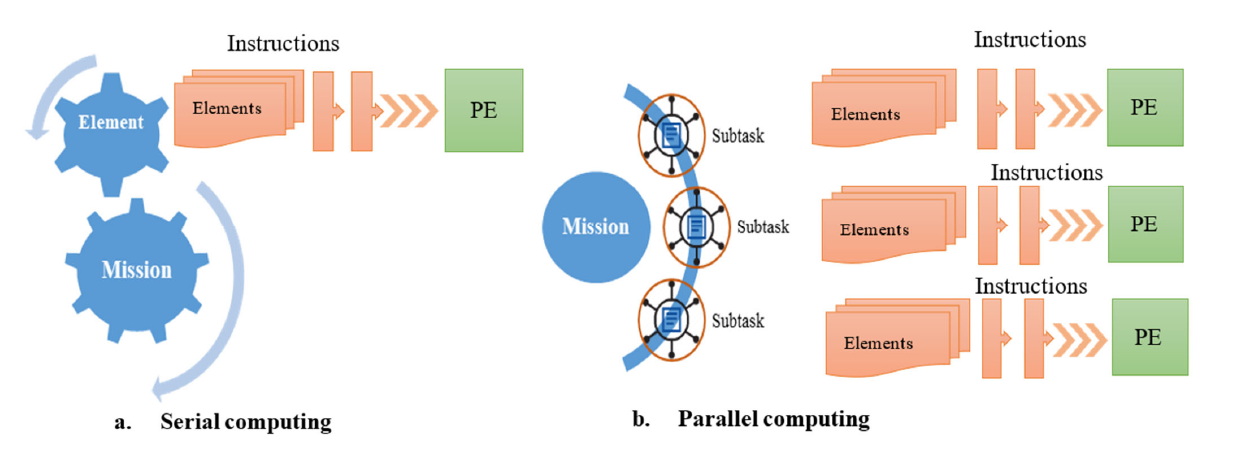
Figure 7. Sequential computing and parallel computing.